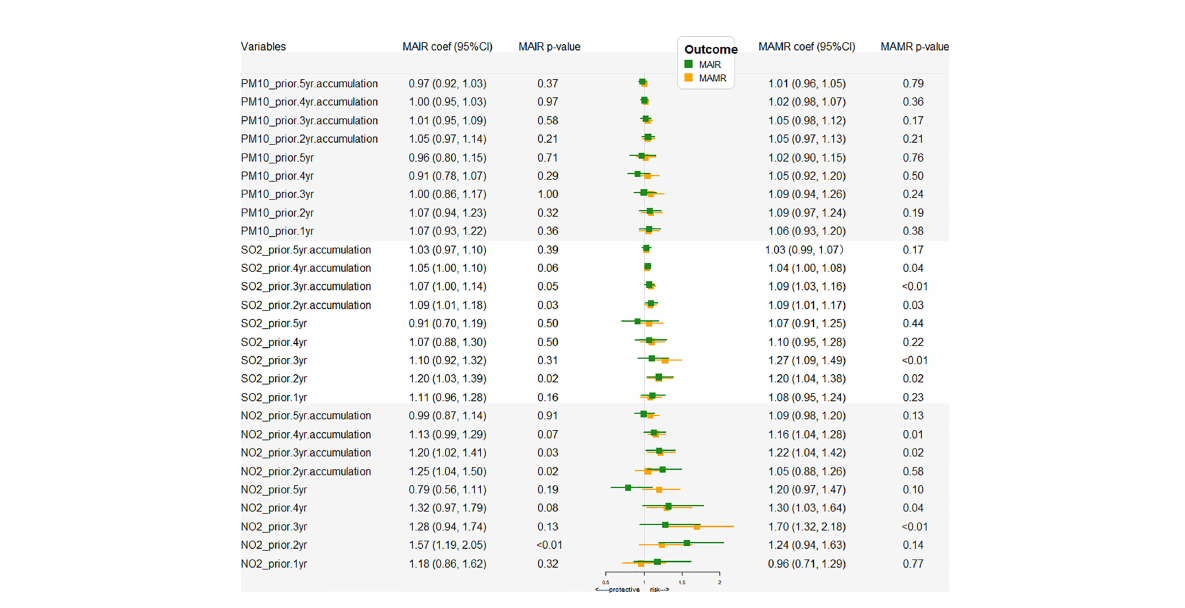
FIGURE 5 Air pollutant exposure-related RRs of MAIR and MAMR with a 5-year moving window. YAV, yearly average values ( m g/m 3 ). RR, risk ratio (with 95% CI); MAIR, male age-adjusted incidence rate; MAMR, male age-adjusted mortality